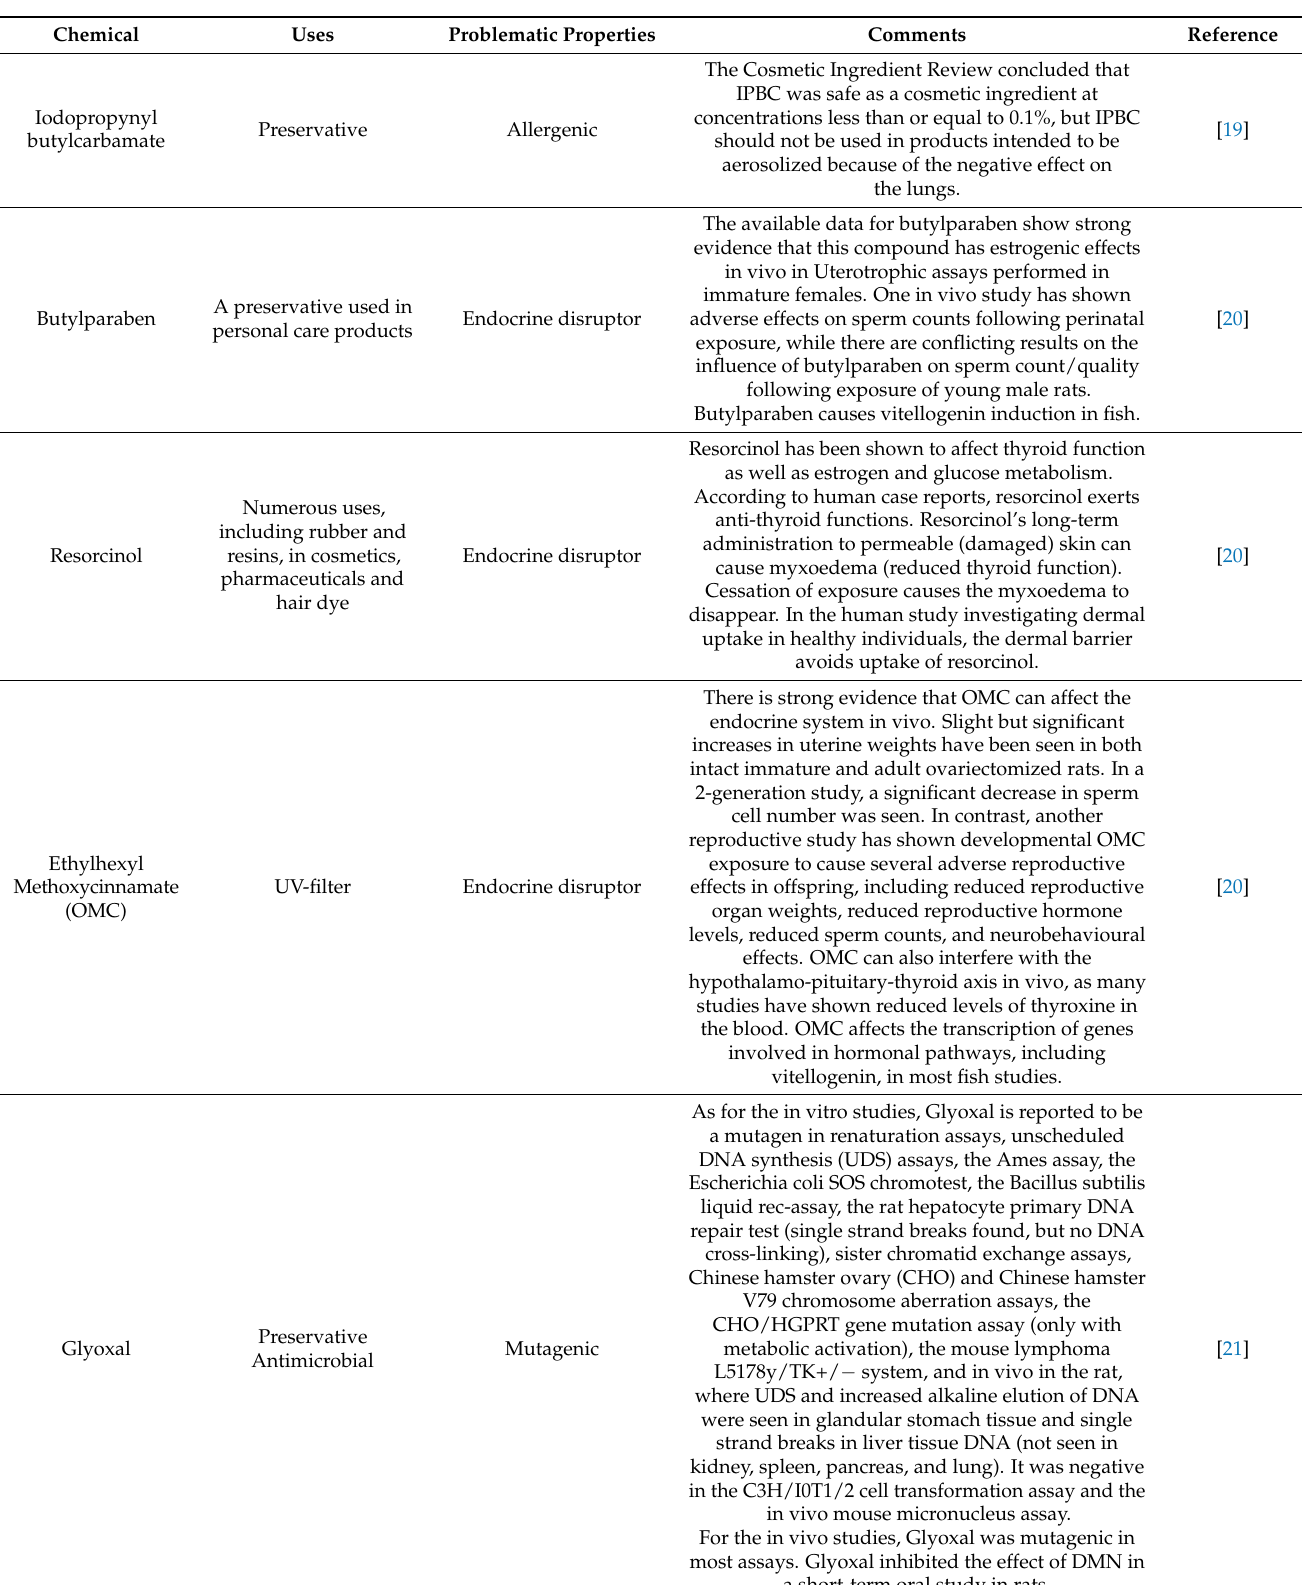
Table 1. Major chemicals found, their uses, and problematic